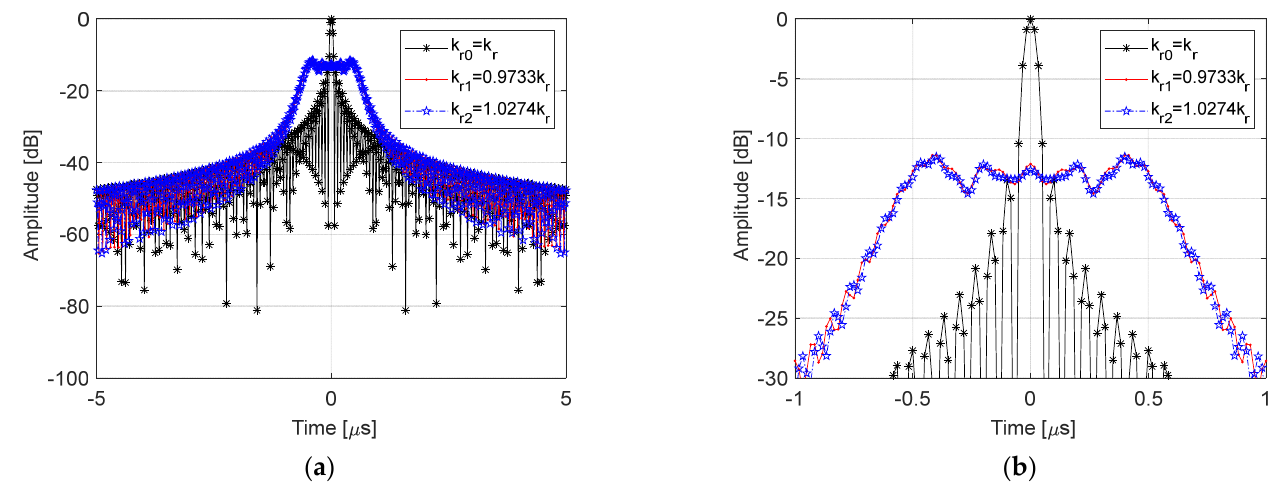
Figure 6. ( a ) Pulse compression results in different frequency modulation rates and ( b ) its zoom in results.